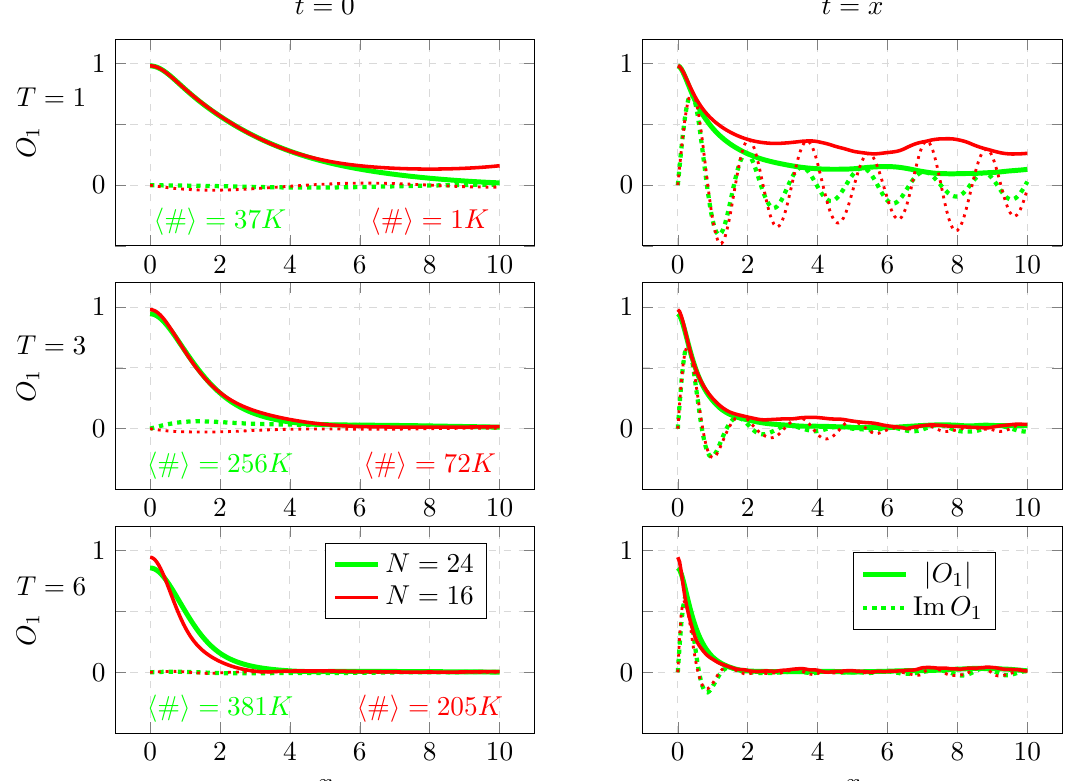
Figure 20: Numerical calculation of O : = 〈 Ψ † ( 0,0 ) Ψ ( x , t ) 〉 via the algorithm, plotted 1 against position x . Green lines have N = L = 24, red N = L = 16. From top to bottom, temperature increases through T ∈ { 1,3,6 } . The left column is the static ψ -operator expectation value, right the ray x / t = 1. The box size used is β = 4, interaction parameter c = 4. Each numerical plot is a flat average over 50 sampled bra states. The average number of ket states 〈 # 〉 visited per bra is printed on the left